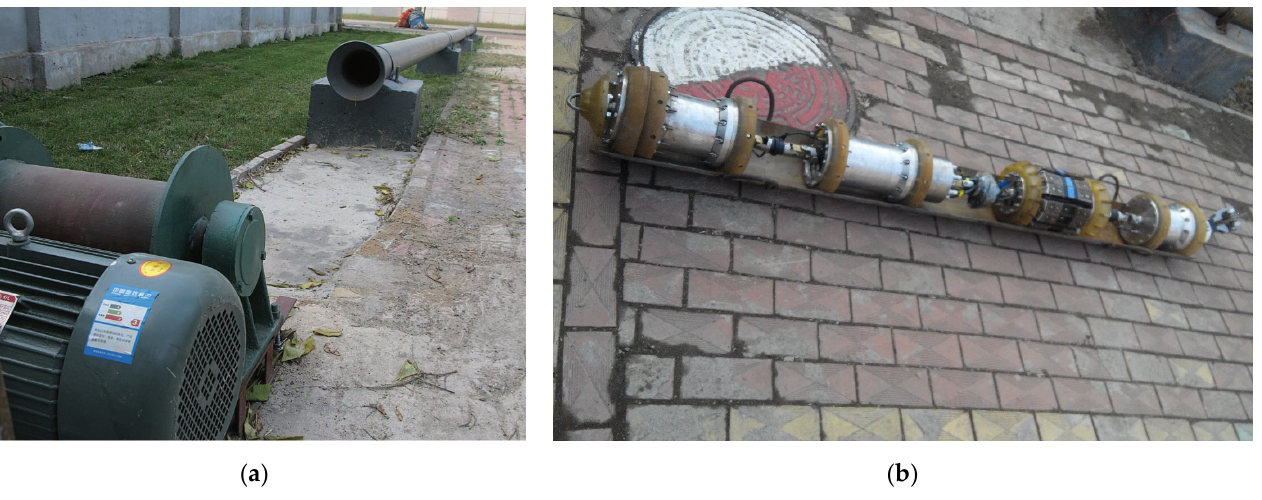
Figure 8. The picture of the non ‐ standard defect.